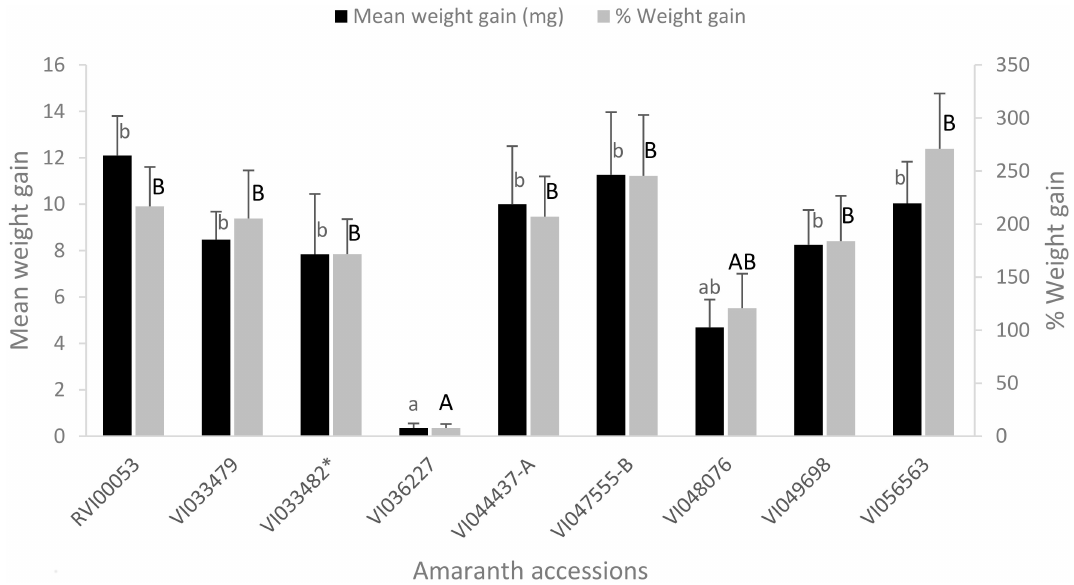
Figure 1. Weight gain (mg) and percentage weight gain (mean ± SE) by larvae of S. recurvalis when fed on different amaranth accessions for 48 h. (Mean weight gain (% weight gain) with the same lower (upper) case alphabet is not significantly different at p < 0.05, (Tukey’s test)). * Susceptible